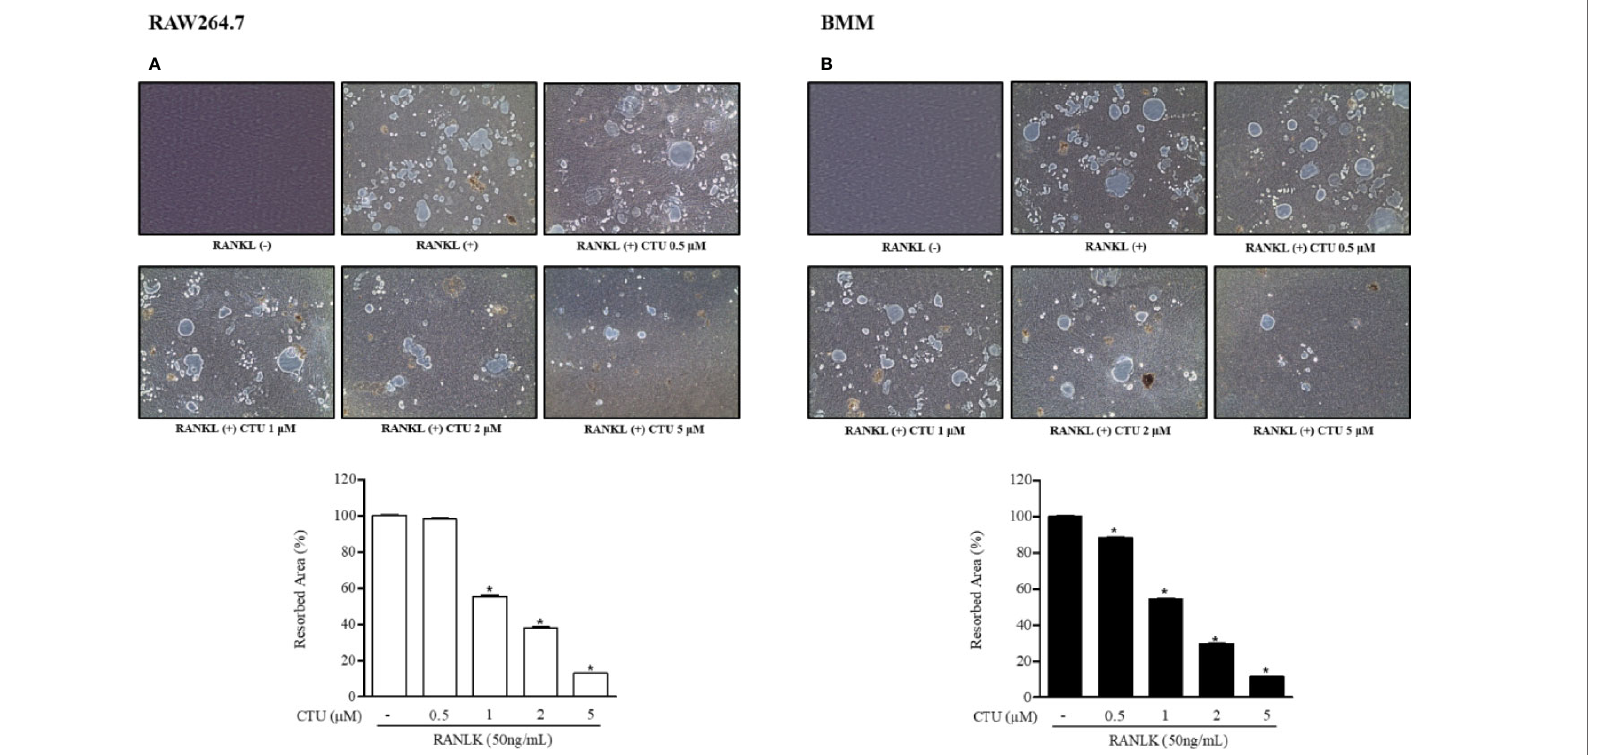
FIGURE 4 | The effect of CTU on osteoclast bone resorption in RANKL-induced RAW 264.7 (A) and BMM (B) cells. The cells were treated with different concentrations of CTU in the presence of RANKL. Total resorption pit area was measured and the results are shown as % of RANKL treatment. Pit formation assay of osteoclasts and quanti fi cation of pit area. * p < 0.05 compared with the only RANKL-treated